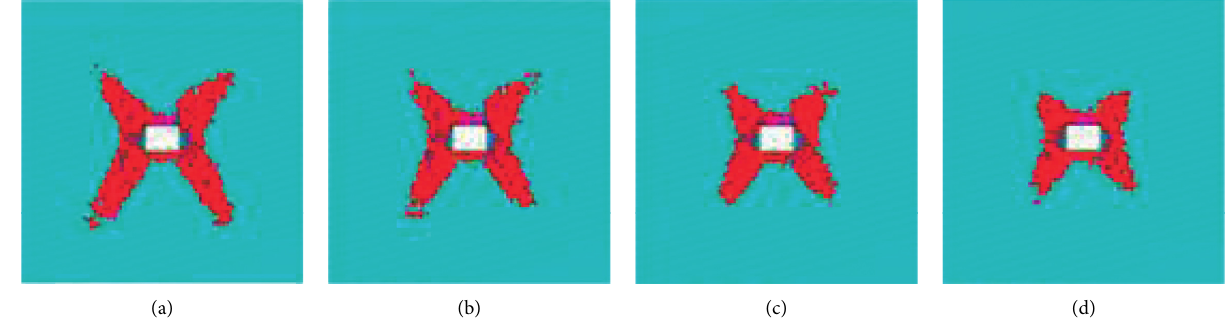
Figure 10: Morphology of plastic zone under different strata cohesion. (a) 2.81MPa. (b) 3.01 MPa. (c) 3.21 MPa. (d) 3.41MPa.